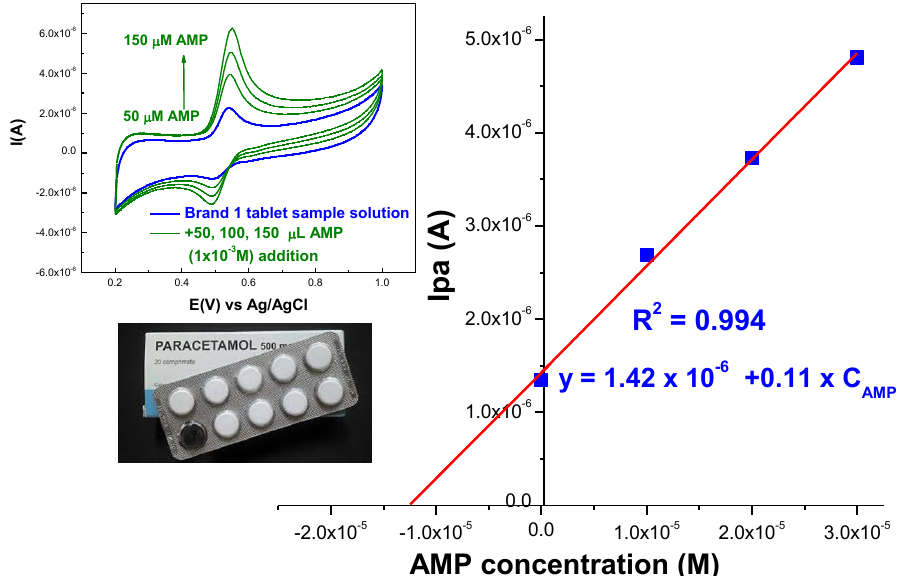
Figure 9. Calibration plot obtained for the standard addition method in case of paracetamol-containing solutions obtained from Brand 1 real tablet sample; Inset : CVs recorded after spiking AMP from the stock solution (1 mM) supporting electrolyte acetate buffer (pH 4.4) solution; scan rate 10 mV/s.